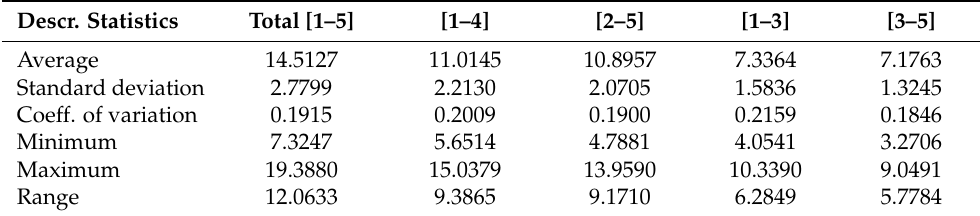
Table 9. The descriptive statistics of the mean SAVI cumulative values across all cumulative ranges and pilot fields.